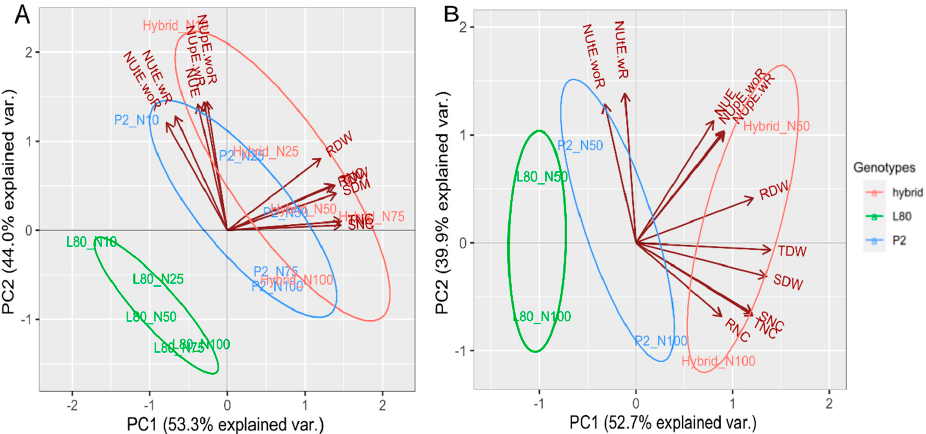
Figure 2. Principal component analysis (PCA) Expt. 1 ( A ) and Expt. 2 ( B ).